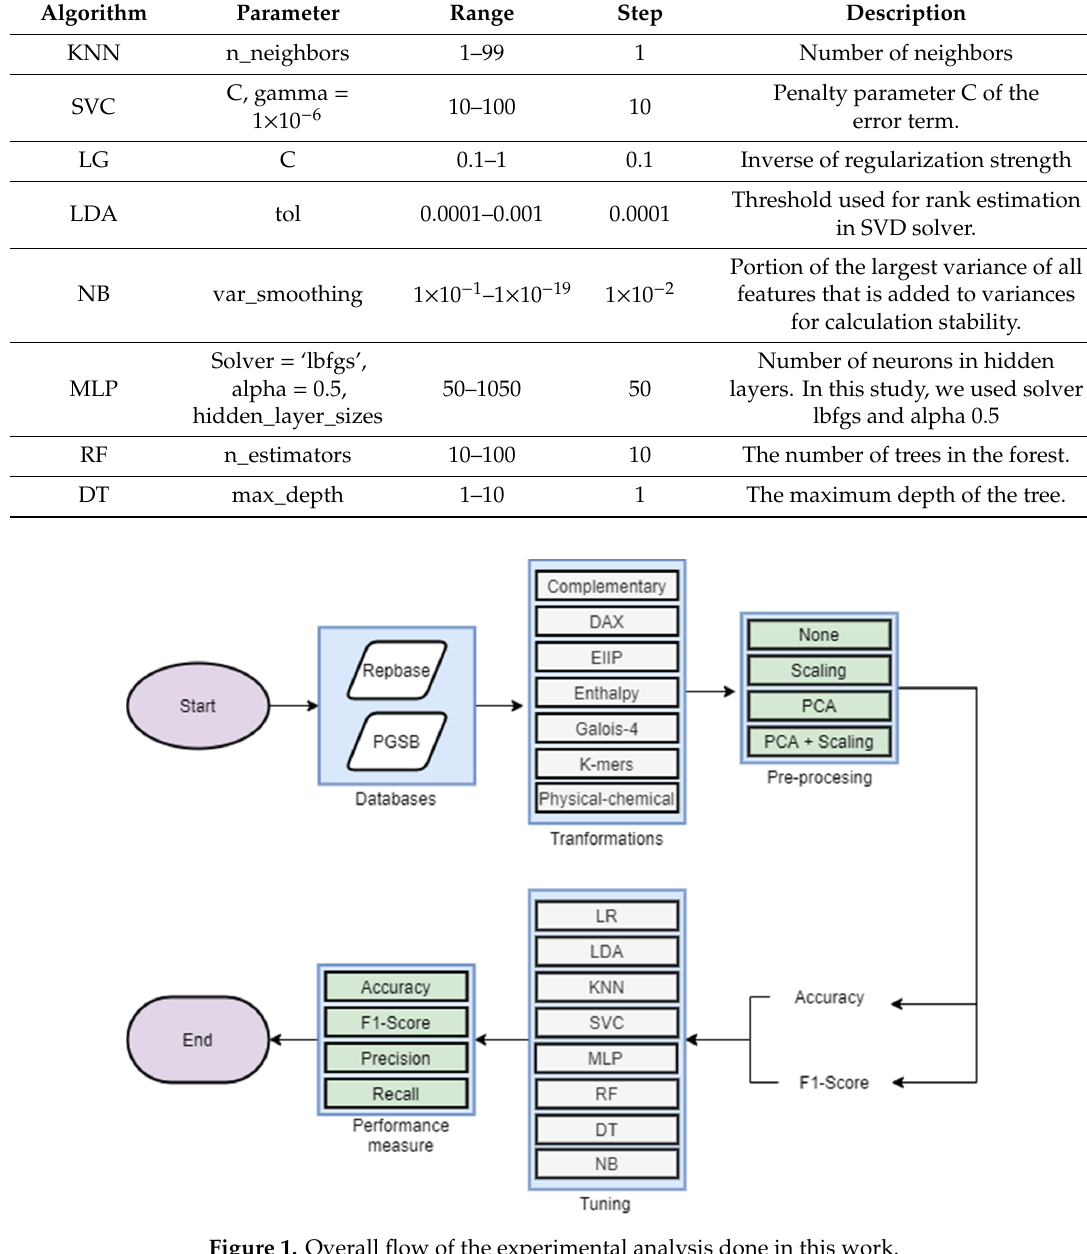
Figure 1. Overall flow of the experimental analysis done in this work. Table 4. Description of experiments